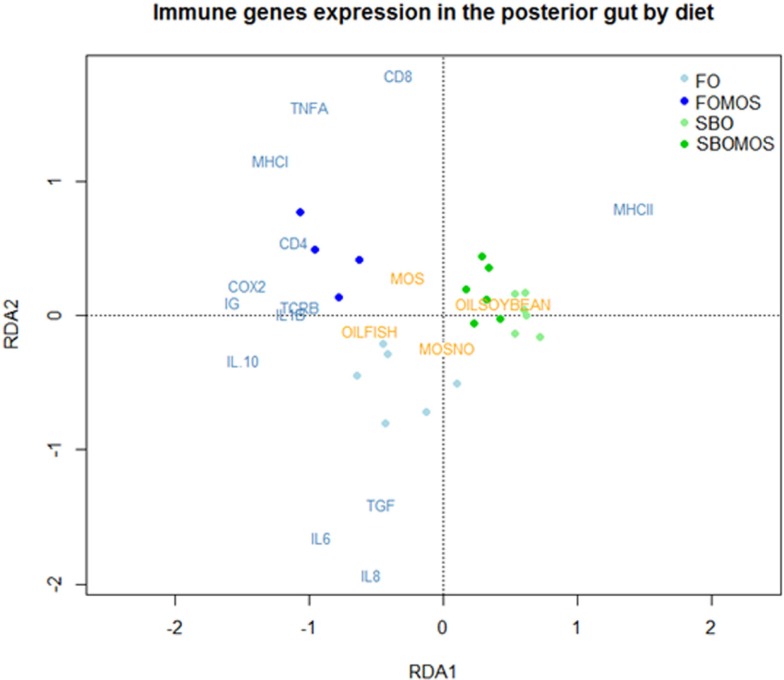
Redundancy analysis (RDA) to study the variability posterior gut relative gene expression as response dietary treatment. The points correspond to the tanks and are colored according to their diet, being FO, fish oil; FOMOS, fish oil and MOS; SBO, soybean oil; SBOMOS, soybean oil and MOS.